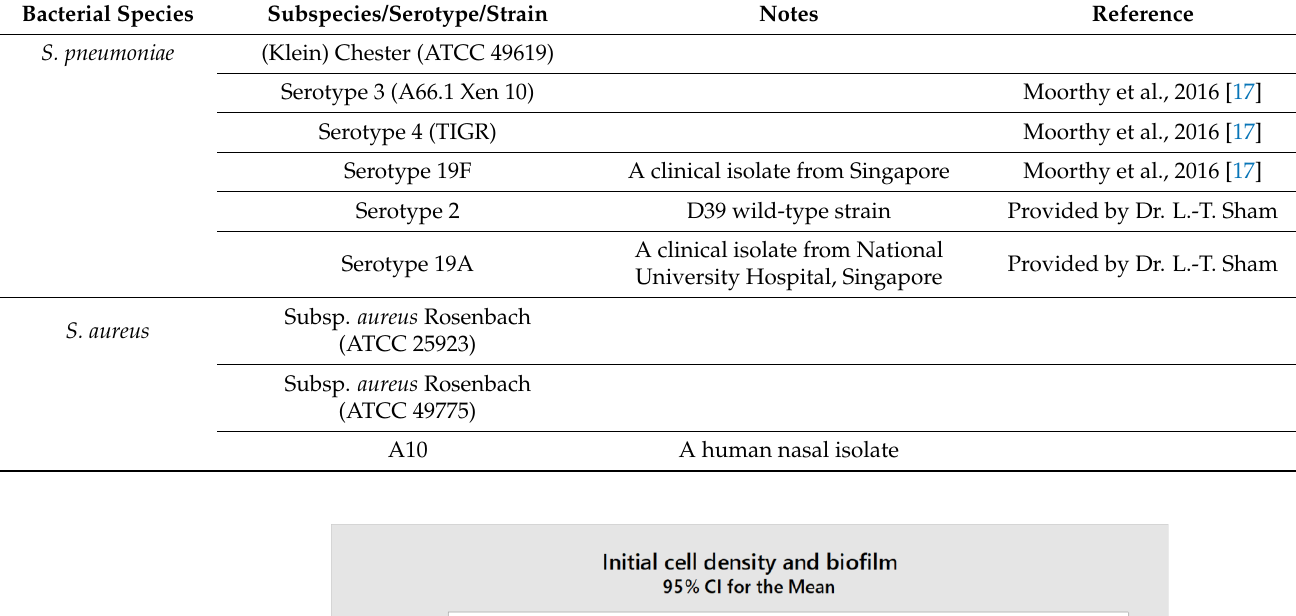
Table 1. Bacterial strains initially screened and analyzed in this study.